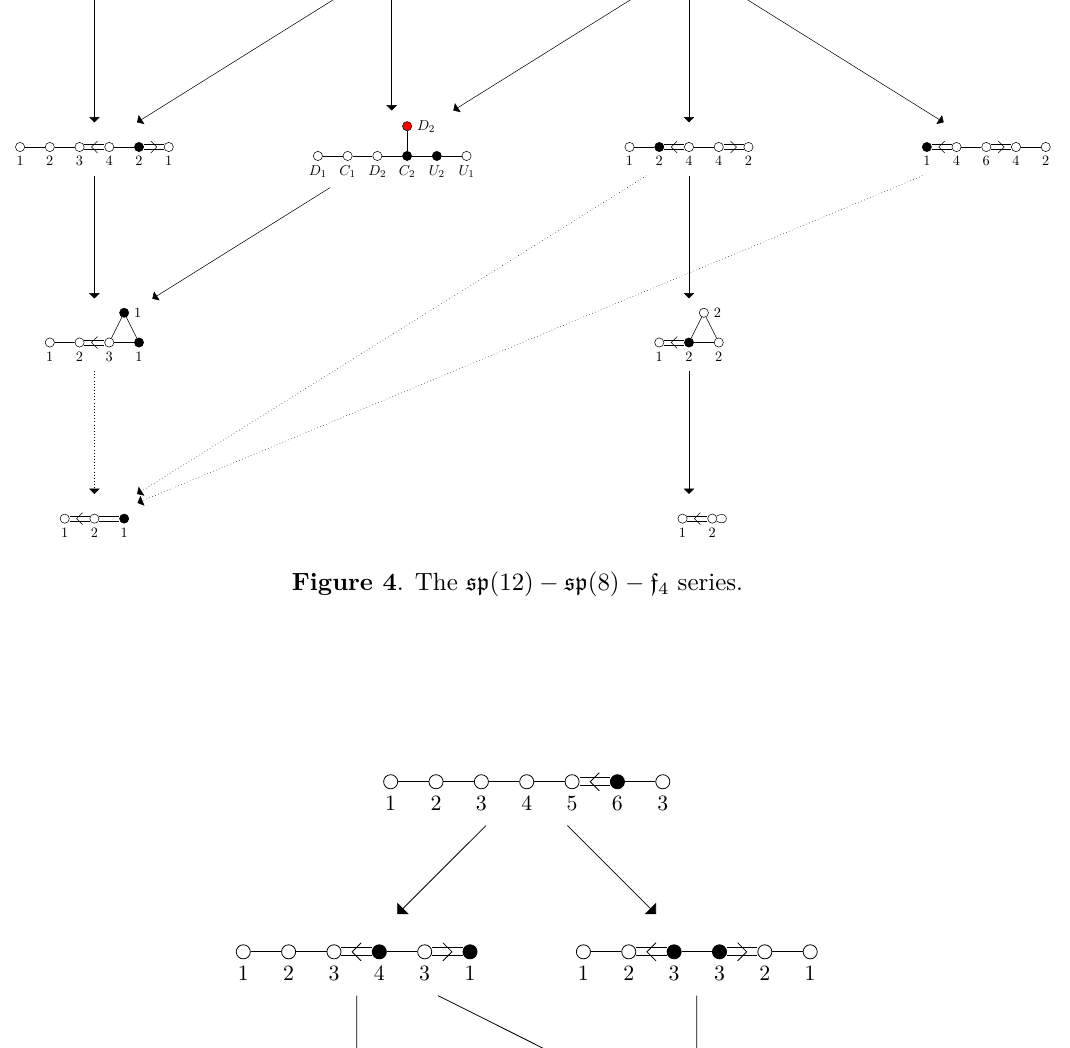
Figure 4 . The sp (12)